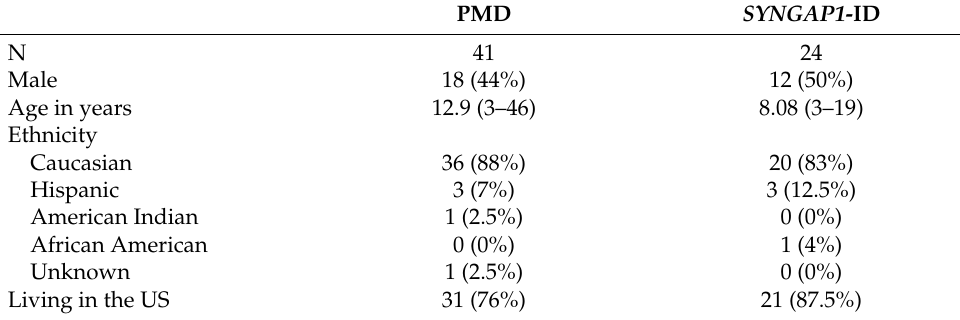
Table 1. Demographic